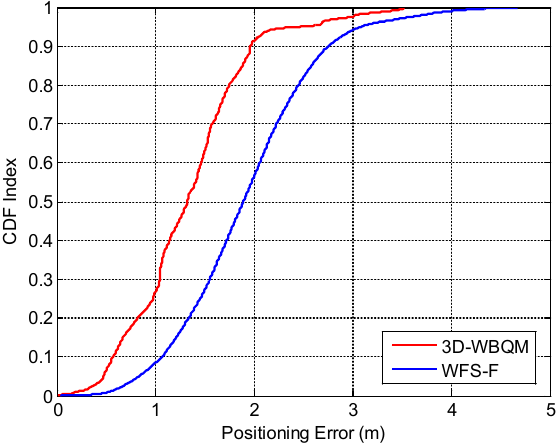
Figure 17. Comparison result of the 3D-WBQM framework and the WFS-F.